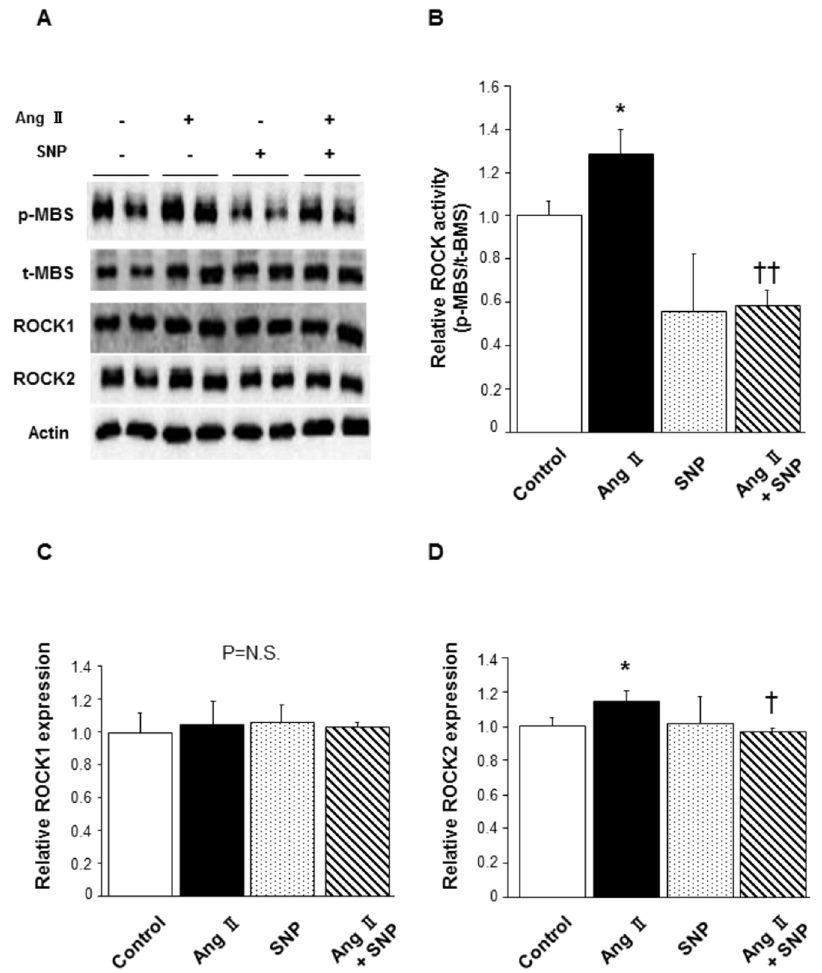
Figure 3. Effect of SNP on Ang II-induced ROCK activation in human aortic VSMCs. Human aortic VSMCs were treated with a vehicle or SNP (40 m mol/L) for 3 hours and stimulated with saline or Ang II (40 m mol/L) for the last 1 hour. (A) Representative results of Western blot analysis for p-MBS, t-MBS, ROCK1, ROCK2, and actin. (B) Quantitative analysis of relative ROCK activity (p-MBS/t-MBS). (C) Quantitative analysis of relative ROCK1 expression. (D) Quantitative analysis of relative ROCK2 expression. n=4 in each group. *P , 0.05 compared to control; {{ P , 0.01 compared to Ang II. { P , 0.05 compared to Ang II.